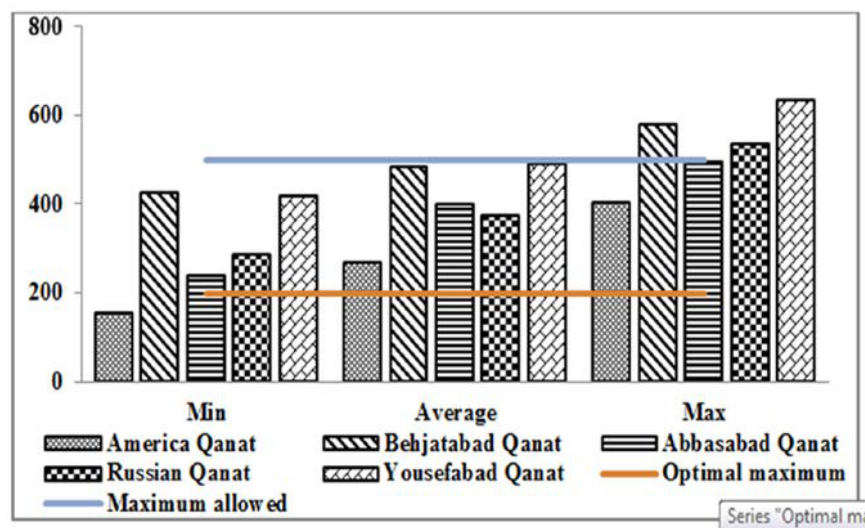
Fig. 5: Total hardness and its comparisons with the WHO and the National Standard of Iran